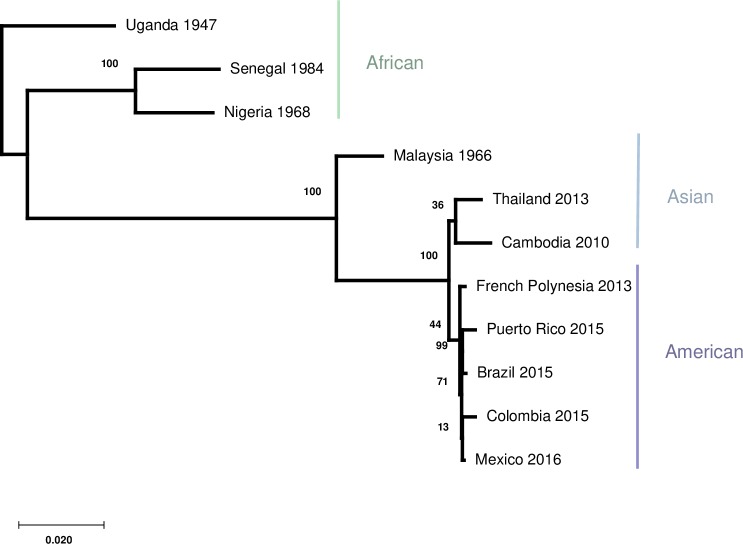
Molecular phylogenetic analysis by maximum likelihood method.The percentage of trees in which the associated taxa clustered together is shown next to the branches. The tree is drawn to scale, with branch lengths measured in the number of substitutions per site. Colored bars correspond to virus strain region of isolation.